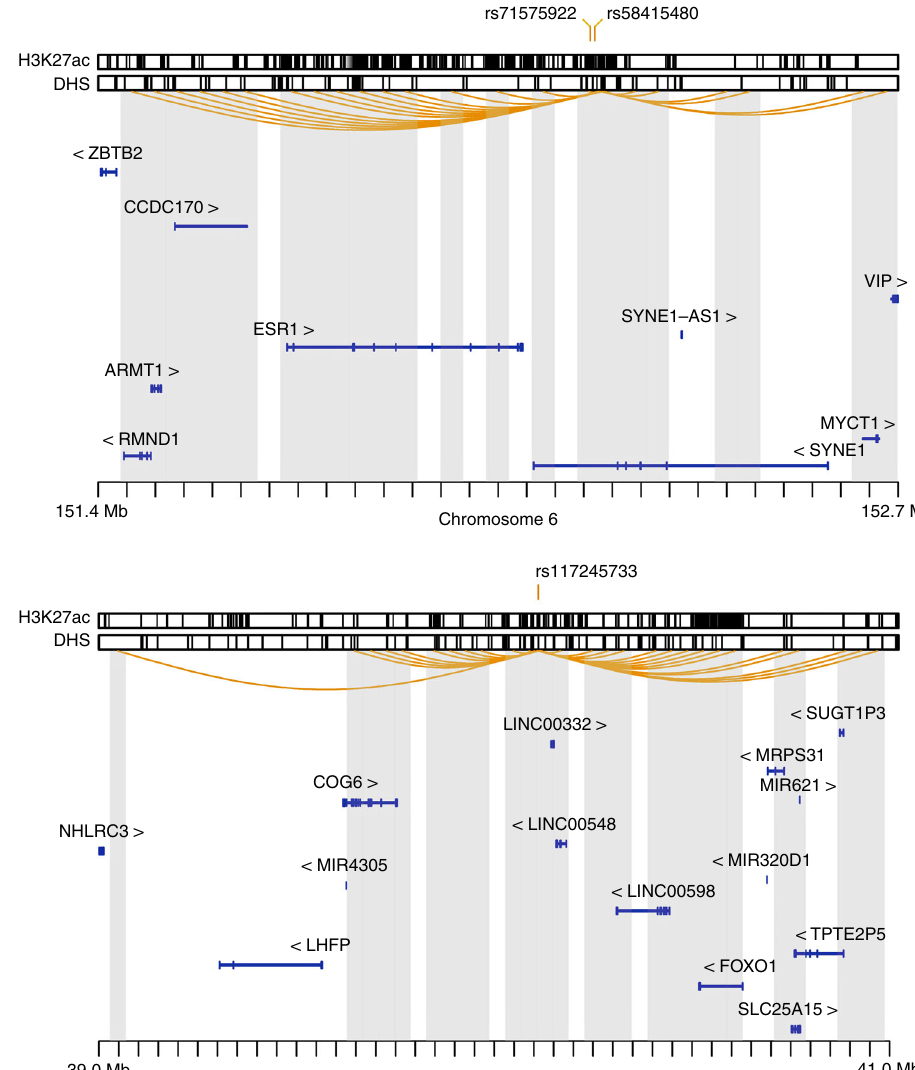
Fig. 2 Leiomyoma risk variants intersecting with regulatory regions and their candidate target genes. Two loci on chromosomes 6 (upper panel) and 13 (lower panel) are shown as examples. Acetylation of lysine residue K27 of histone H3 (H3K27ac) and open chromatin (DHS, DNase Hypersensitivity Sites) in the uterus samples are shown as tick marks at the top. At chromosome 6, the lead variant rs58415480 is shown along with the only other variant in the same LD class ( r 2 > 0.8), rs71575922. At chromosome 13, rs117245733 is in an LD class by itself, i.e., does not have strongly correlated markers. Candidate target genes were identi fi ed by the analysis of available chromatin interaction maps, shown on the fi gure as orange arcs. The shaded regions represent regions found in contact with the regulatory